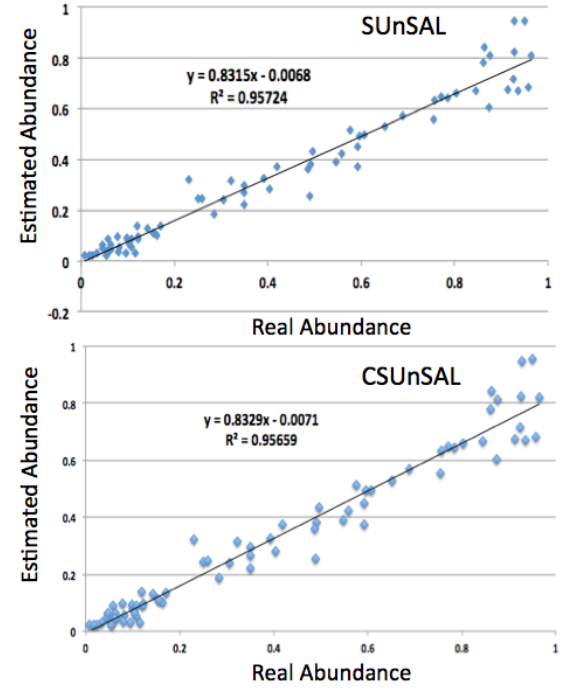
Figure 5. BDF plots of vegetation fraction at each of the sampled locations and regression lines of ground cover proportions (real abundances) versus estimated abundances from SUnSAL and